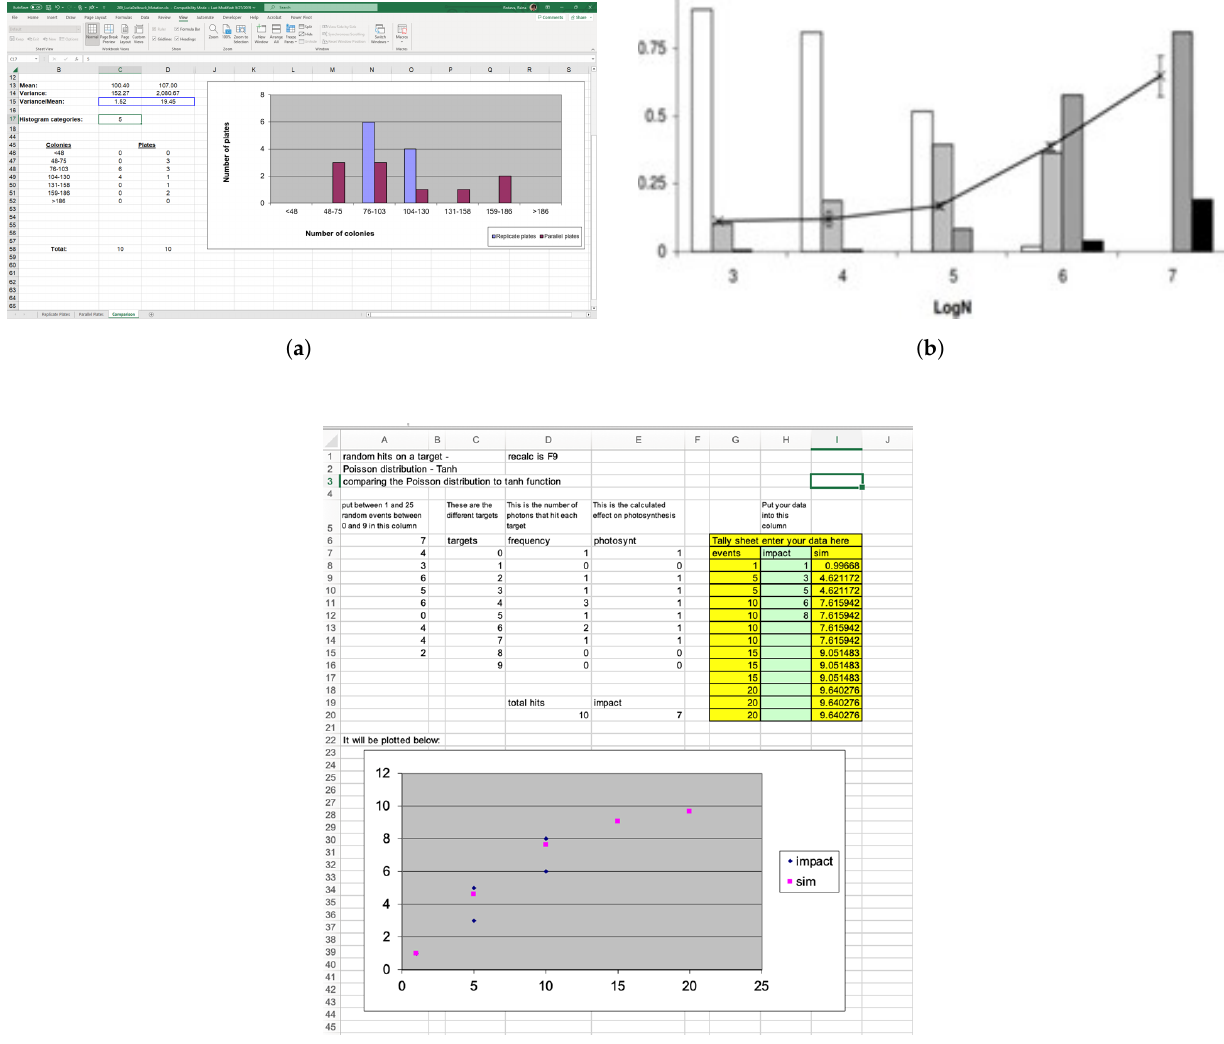
Figure 3. ( a ) Screenshot from one of two workbooks that model the evolution of phage resistance in a bacterial population under the directed mutations and the spontaneous mutations hypotheses. “Luria-Delbruck. A module of the Biological ESTEEM Collection” (Weisstein, Jungck, and Green (2015) https://bioquest.org/esteem/esteem_result.php accessed on 28 February 2023), ( b ) Mutate Image: “Selective mutation frequency distribution and fitness gain after 250 generations for